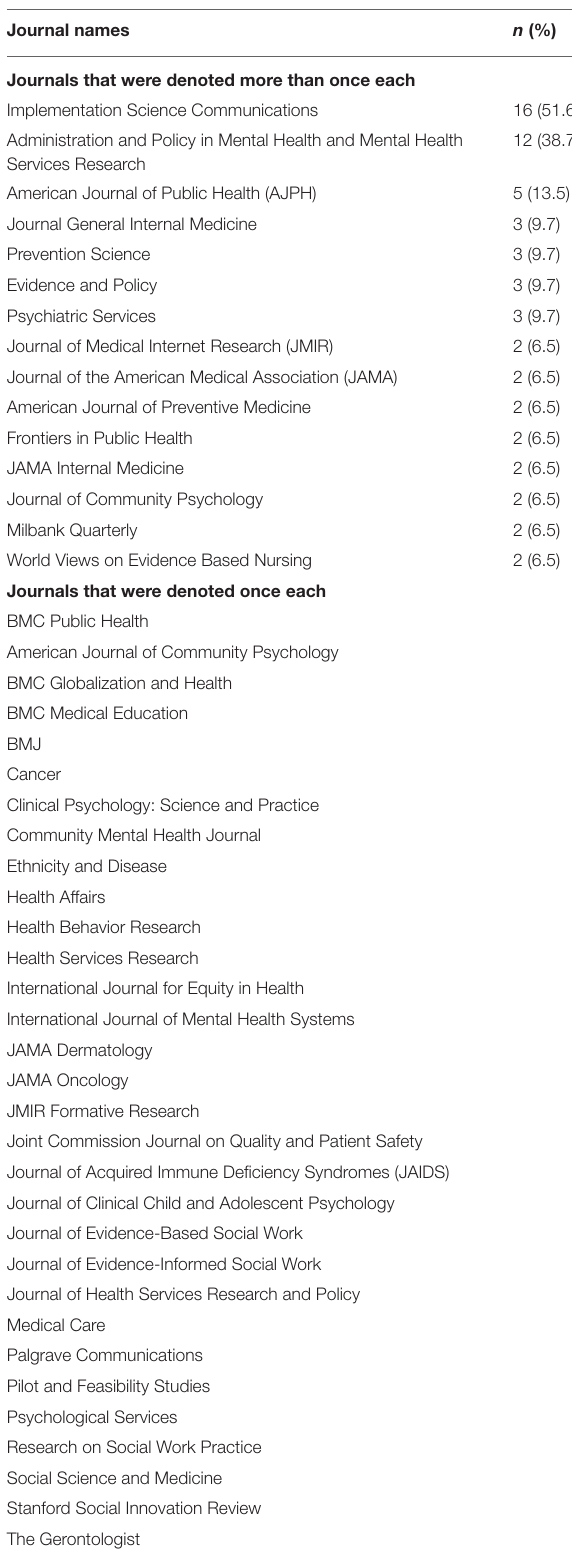
TABLE 1 | Search string INSPECT project in PubMed until 31.12.2019 achieved 10,904 hits.